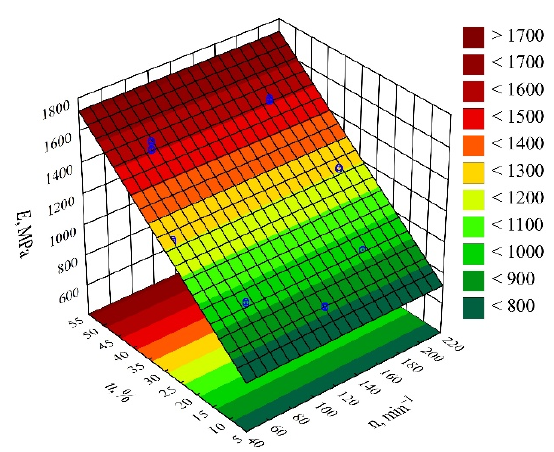
Figure 23. Response surface plot for the Young’s modulus E versus wheat bran content u and screw speed